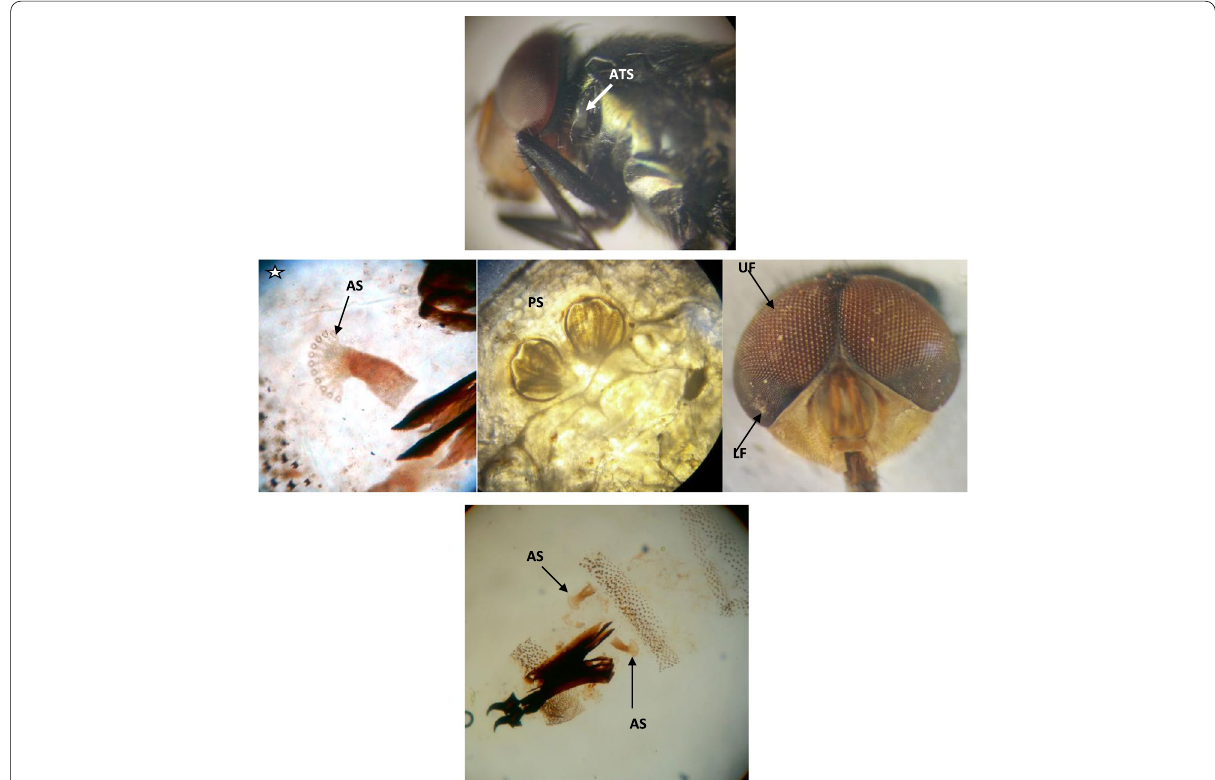
Fig. 1 Gross and microscopic morphological features of Male Chrysomya megacephala (all the pictures were marked picture 400 magnification*). ATS—anterior thoracic spiracle (dark brown); AS—anterior spiracle (11 figner projections); PS—posterior × spiracle (incomplete preitreme, stright stigmal slits, no button); LF—lower eye facets; UF—upper eye